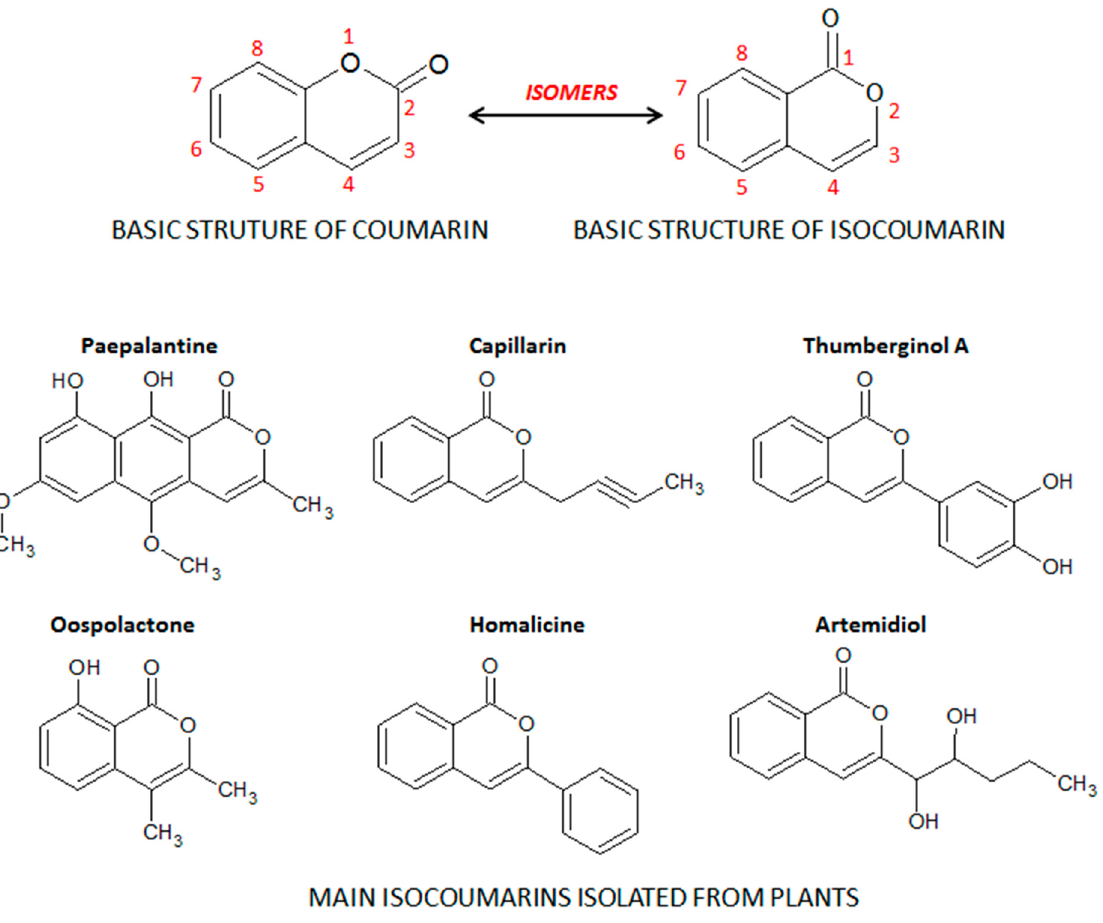
Figure 1. Basic structures of coumarins and isocoumarins and the main isocoumarin derivatives. Chemical structures were drawn using ACD/ChemSketch software.